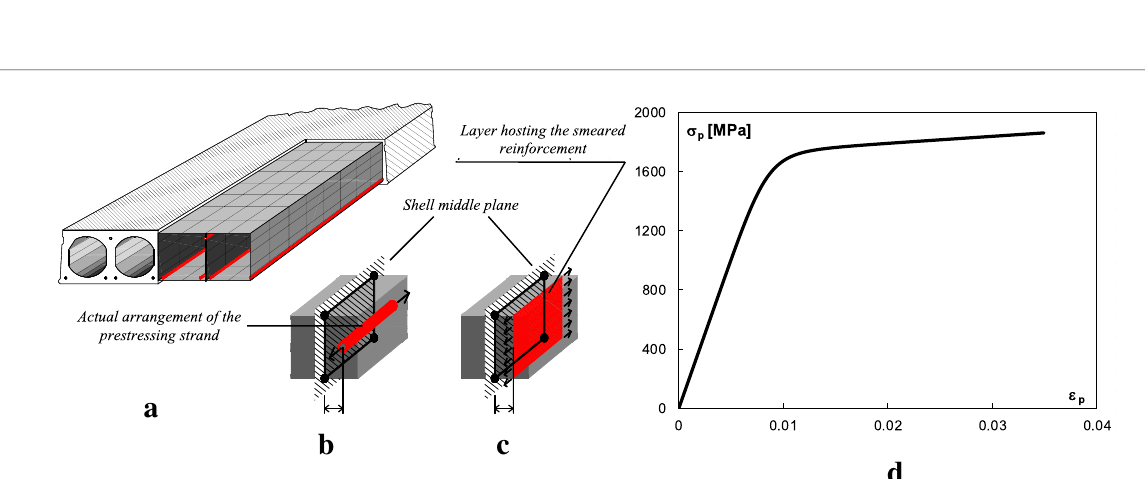
Fig. 10 FE model of HCS: a individuation of the middle plane of HCS cross-section; b cross section discretization, with vertical shell elements modeling concrete fillings (in red, for flexural tests only); c resulting mesh with shell elements adopted for specimens H50-s.